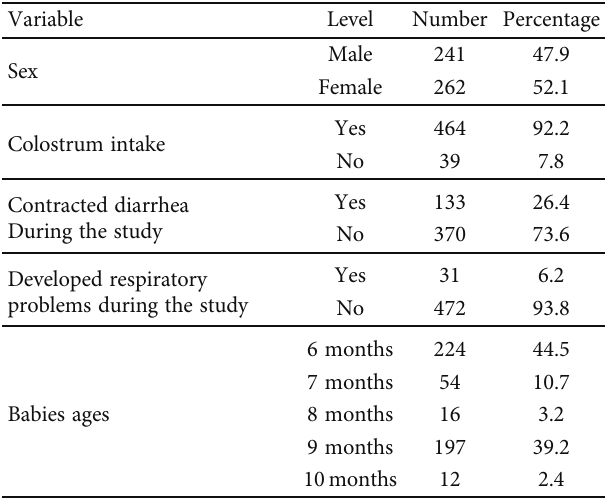
Table 2: Demographic distribution and characteristics of